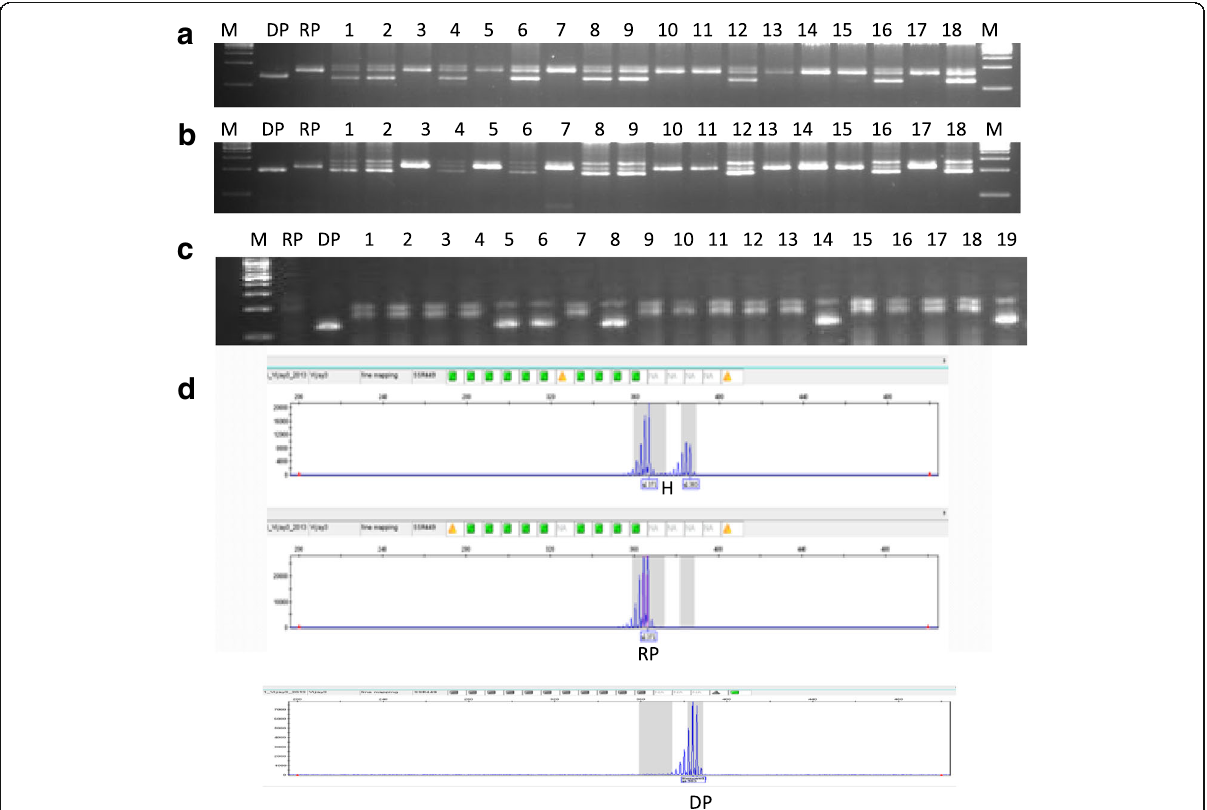
Fig. 2 Foreground ( a , b ) and recombinant ( c , d ) selection in backcross F 1 lines of variety Ranjit with linked SSR markers a . nkssr 04-11 b . nkssr 04-19. c . RM2441 using 3.5-4% metaphor agarose gel electrophoresis, and d HVSSR 04-49 by capillary electrophoresis. M=DNA size markers,